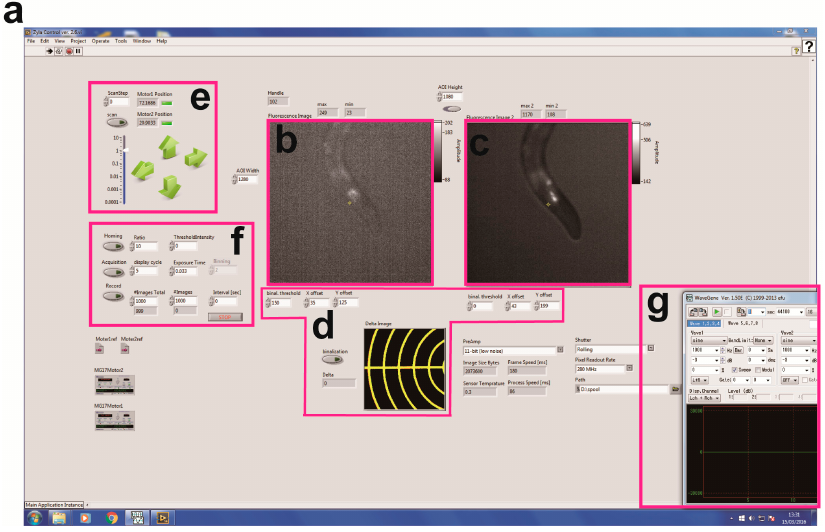
Figure 2. Screenshot for the machine vision software and each control panel. ( a ) Overall photo of the software written on LabVIEW. ( b , c ) GCaMP ( b ) and TagRFP ( c ) images. ( d ) A panel for calibration of the coordinates between GCaMP and TagRFP images. ( e ) A panel for controlling the X-Y position of motorized stage. The coordinate is recorded as a csv file. The stage can be also driven by screw actuators under joystick control (Thorlabs, Newton, NJ, USA). ( f ) A panel for image acquisition and tracking. Exposure time, binning and image acquisition rate can be changed in this panel. ( g ) A photo for WaveGene software to control vibration